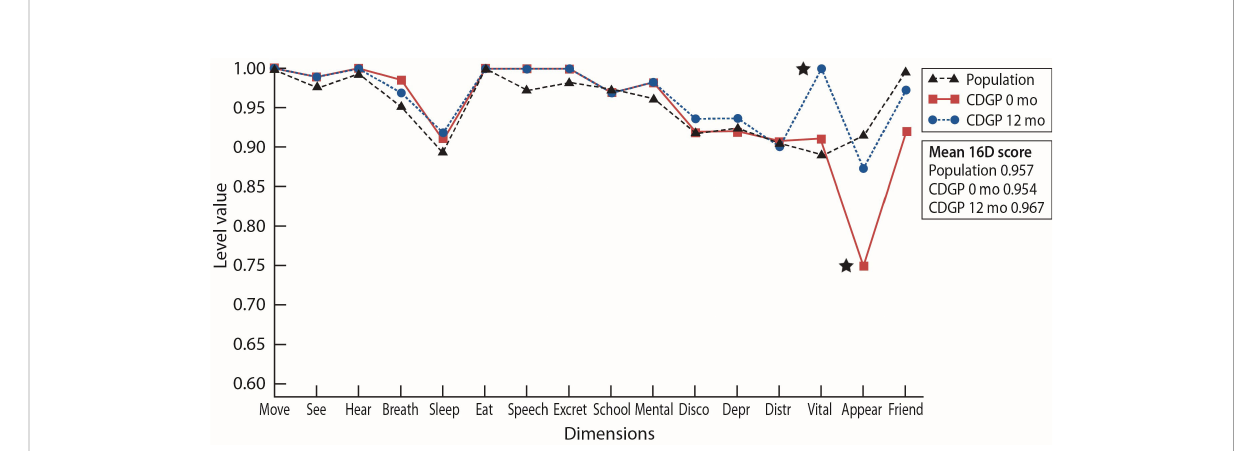
FIGURE 1 The mean 16D pro fi les in male patients with CDGP (n=22) compared with age-standardized general male population (n=163). A higher score indicates a better HRQoL. The star-symbol indicates a statistically signi fi cant (p<0.05) difference between age-standardized general male population and the CDGP male